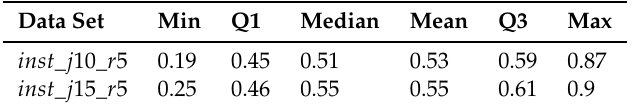
Table 5. X ( I ) value summary for instances of datasets inst _ j 10_ r 5 and inst _ j 15_ r 5, with time limit equal to the optimal solution time for the aggregated fraction model.